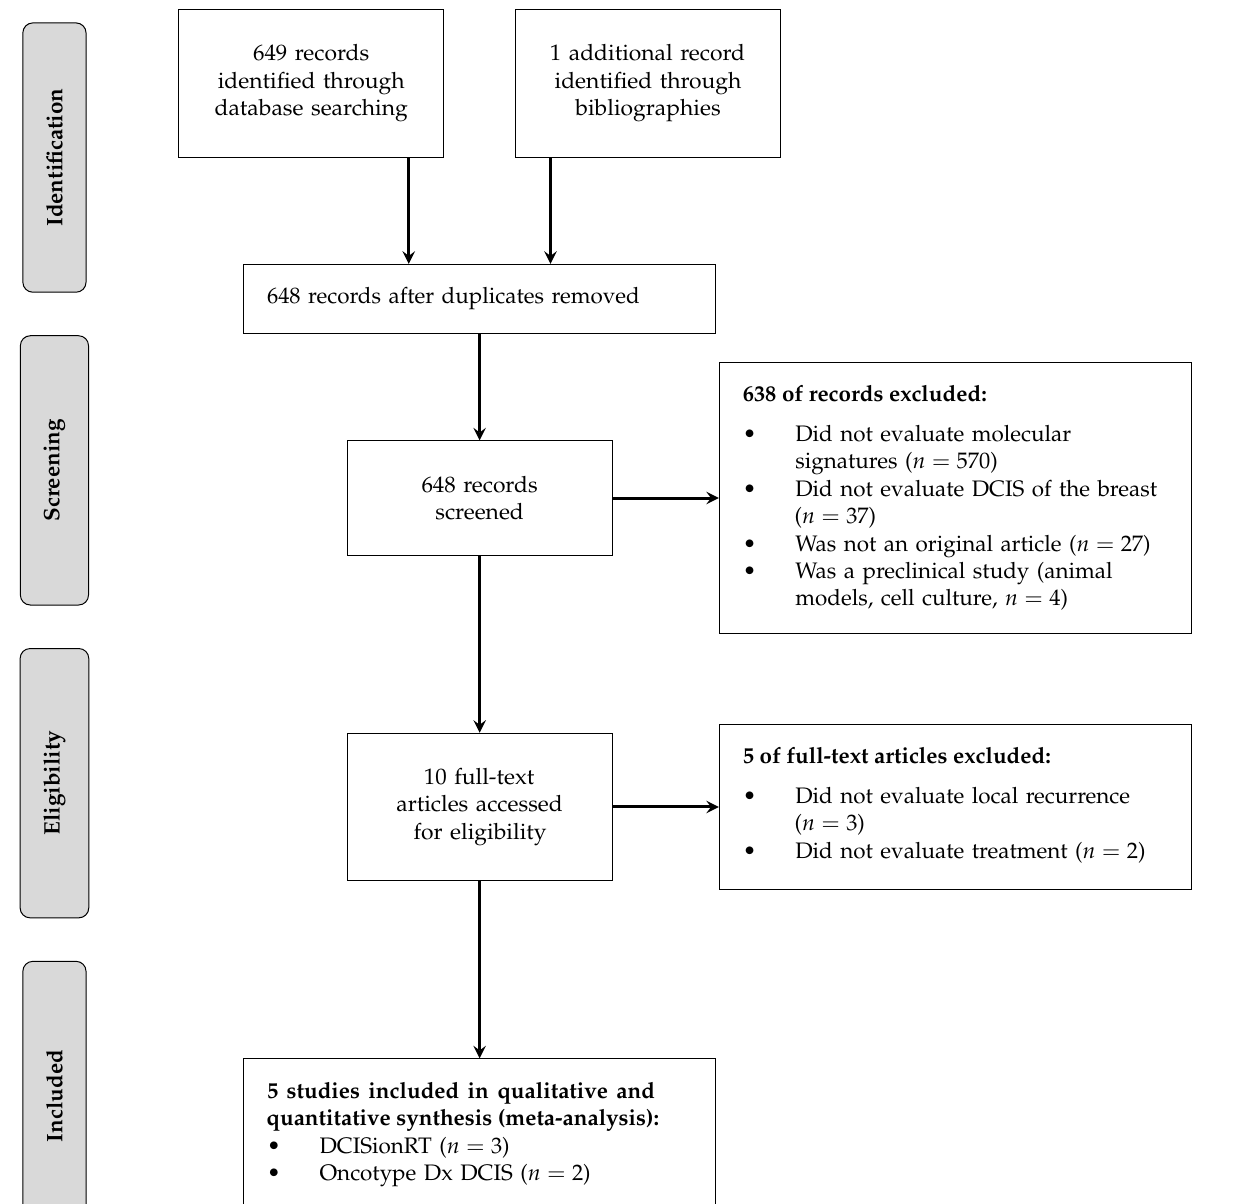
Figure 1. Flow chart diagram (PRISMA). Legend: DCIS = ductal carcinoma in situ; BCS = breast- conserving